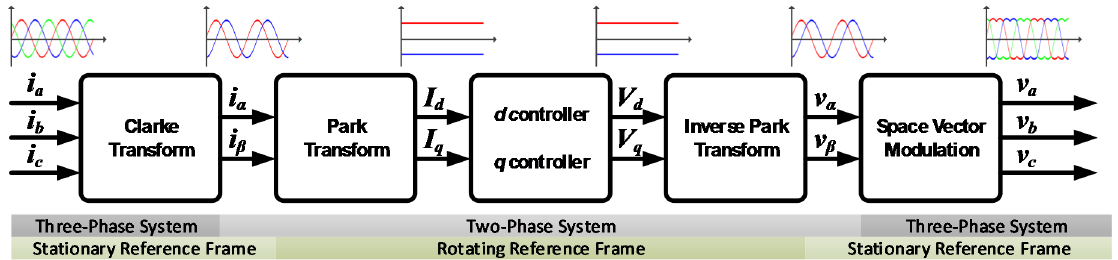
Figure 9. Field-oriented control (FOC) conversion stages and axes system [37].